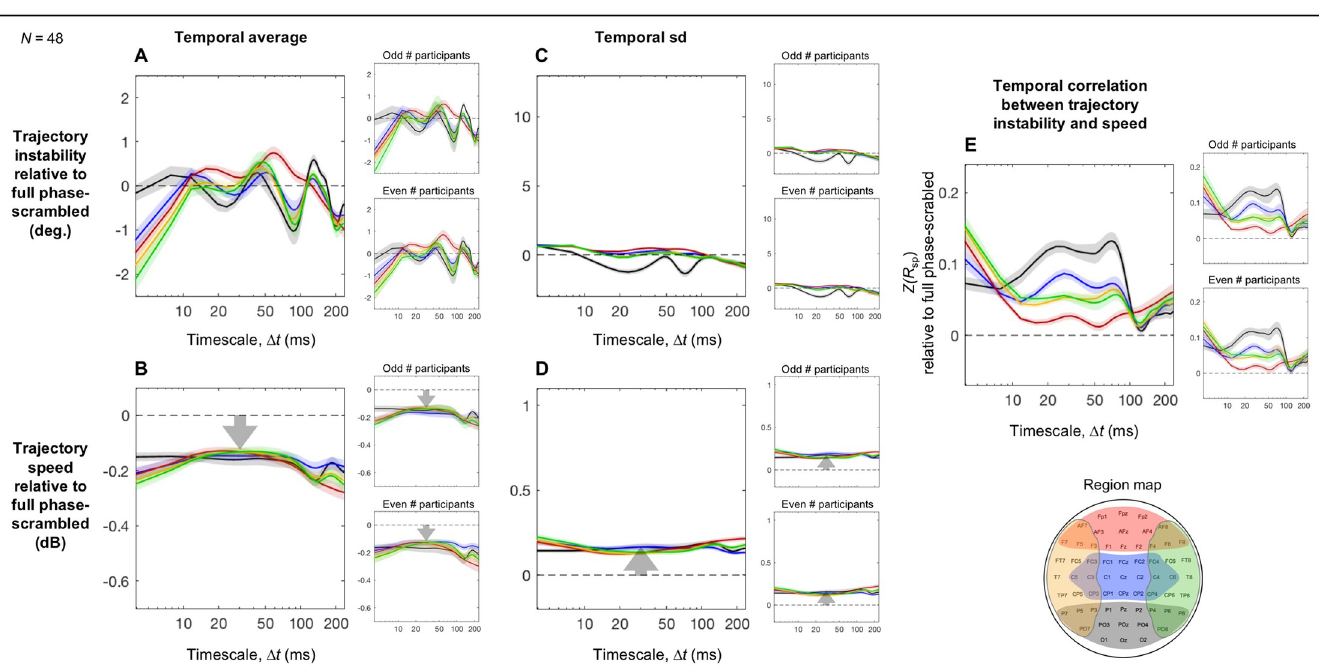
Fig 5. The cross-frequency-phase-relation dependent aspects of trajectory instability and speed and their temporal correlation as a function of timescale Δ t relative to the corresponding cross-frequency phase-scrambled controls (that preserved cross-site within-frequency phase relations). For each plot, the reliability of the data patterns is demonstrated by the accompanying plots on the right showing virtually identical patterns obtained from the odd and even numbered participants. A. Time-averaged trajectory instability as a function of Δ t (real data minus the corresponding phase-scrambled controls). B. Time-averaged trajectory speed as a function of Δ t (real data vs. the corresponding phase-scrambled controls in dB). C. The temporal variability (measured as standard deviation) in trajectory instability as a function of Δ t (real data minus the corresponding phase-scrambled controls). D. The temporal variability (measured as standard deviation) in trajectory speed as a function of Δ t (real data vs. the corresponding phase-scrambled controls in dB). E. The temporal correlation between trajectory instability and speed as a function of Δ t (real data minus the corresponding phase-scrambled controls in z -transformed Spearman r). In all panels, the data for the posterior, central, anterior, left-lateral, and right-lateral regions are shown in black, blue, red, orange, and green curves, respectively (see the region map). The shaded areas represent ± 1 standard error of the mean.